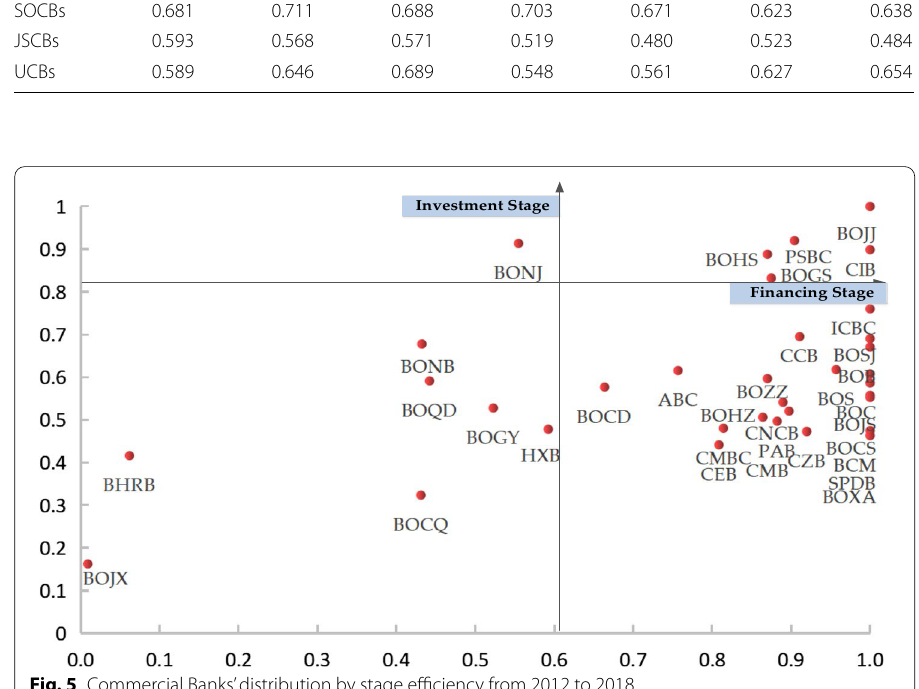
Fig. 5 Commercial Banks’ distribution by stage efficiency from 2012 to